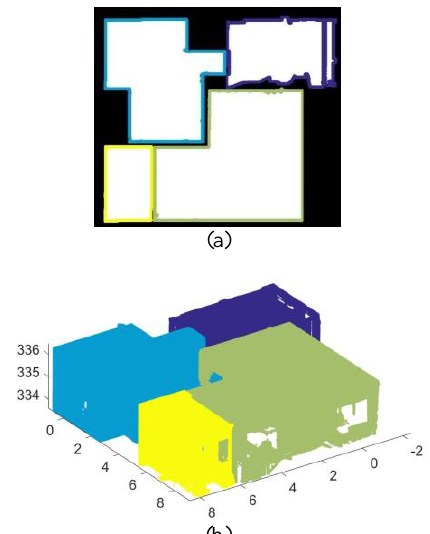
Figure 2. Room segmentation – First floor of the house: (a) Binary image with boundaries of detected 2D regions; (b) Corresponding 3D regions (one colour per room)